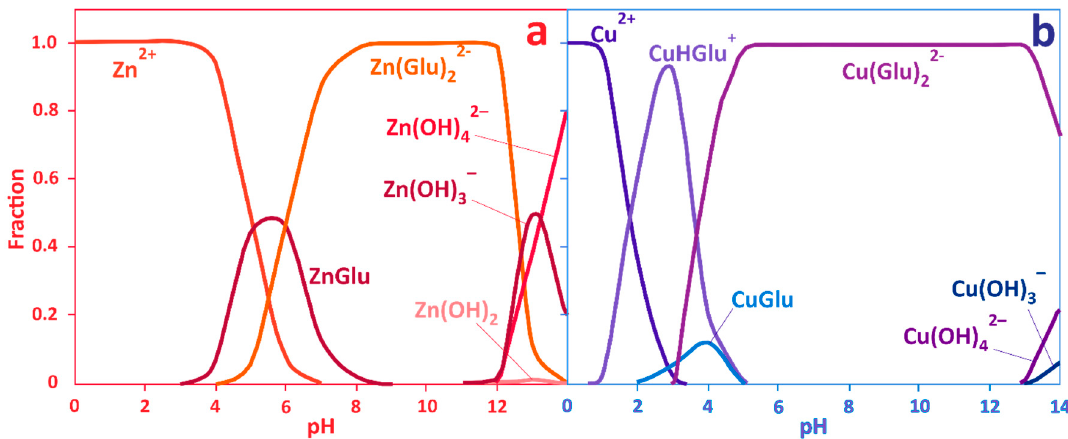
Figure 1. Species distribution of Zn ( a ) and Cu ( b ) in glutamate-H2O system as function of pH. Glutamate concentration 1 M, Zn 2+ 300 mM and Cu 2+ 8 mM.